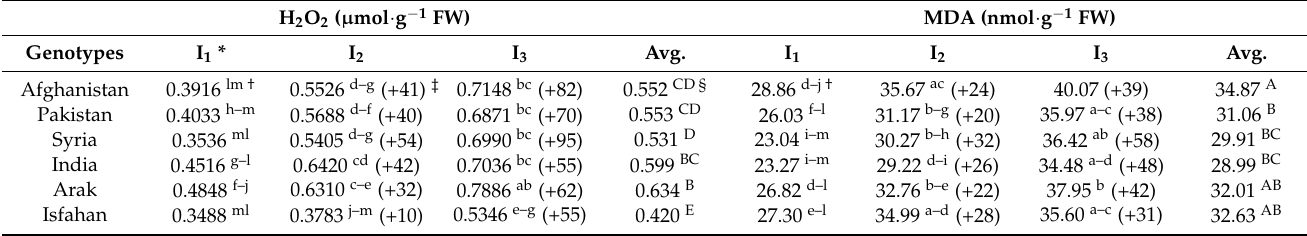
Table 7. Mean comparison of the effect of irrigation regime (I), genotype (G), and their interaction on H 2 O 2 and MDA of black